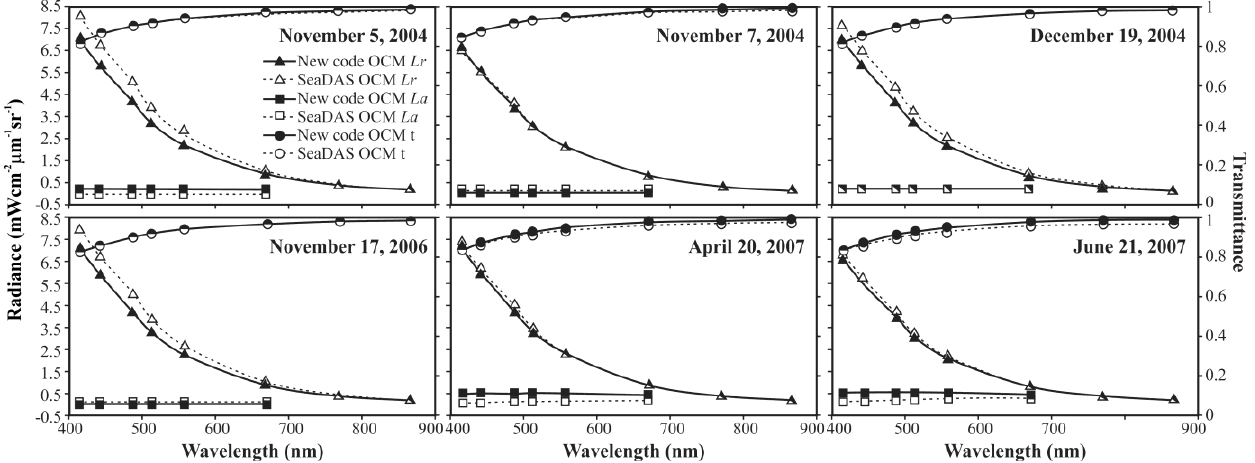
Figure 6. Comparison of Rayleigh path radiance ( L Diffuse transmittance (t) calculated by the new code and SeaDAS at the atmospheric correction sites in each of the OCM